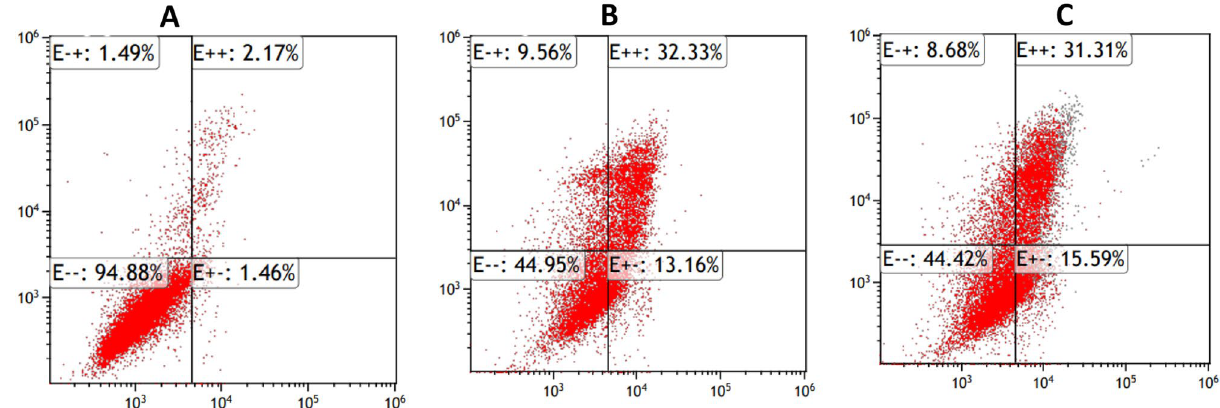
Figure 6. Annexin V-FITC/PI staining for evaluating apoptosis. HCT116 colon cancer cells were treated with free CP ( B ), CP-NPs-50 ( C ) at IC50 concentration for 72 h and compared with untreated cells ( A ). Apoptosis– necrosis ratio was determined by flow cytometry.